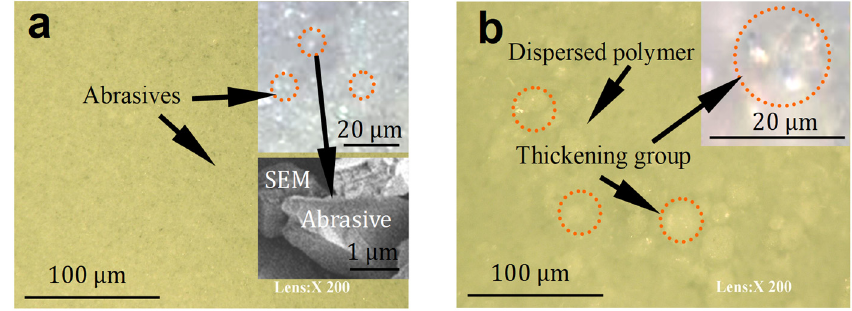
Figure 2: States of the special slurries observed on the VHX - 5000 microscope and SEM: ( a ) initial dispersion and ( b ) thickening